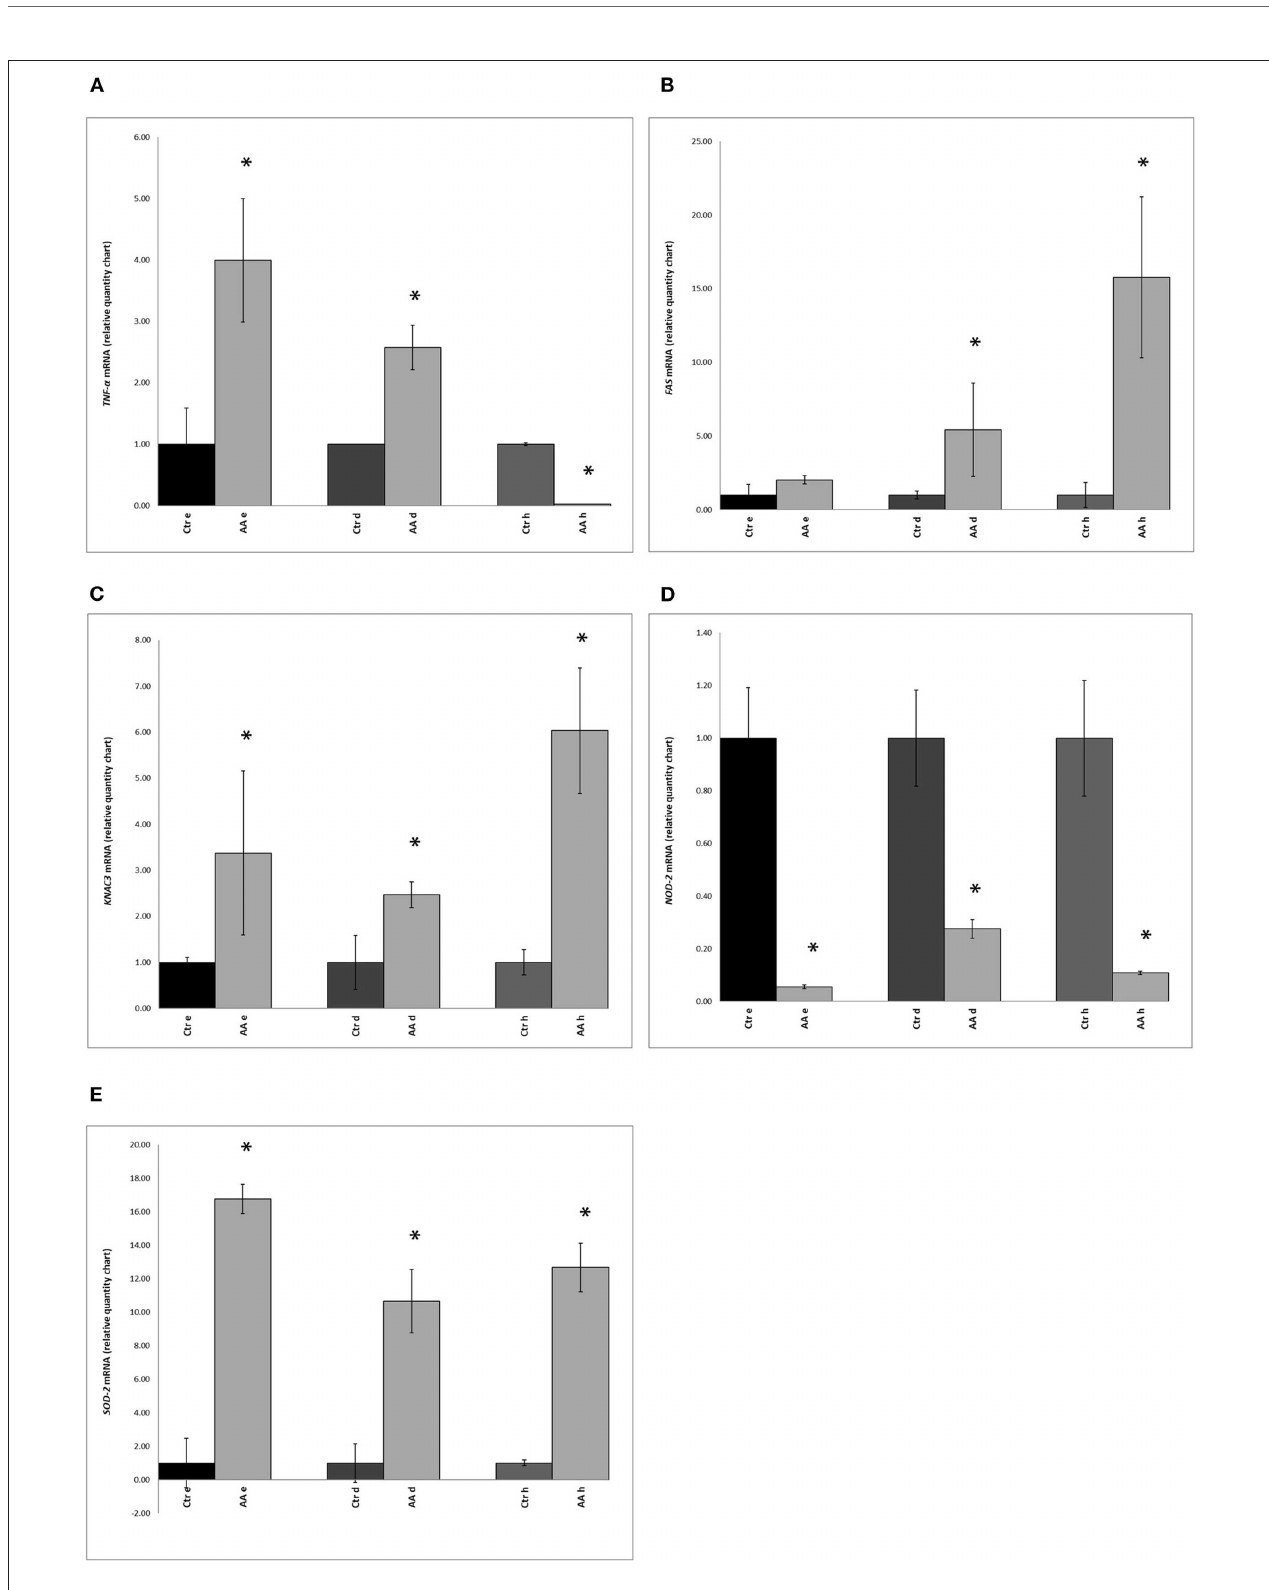
FIGURE 2 | Expression of (A) TNF- α (tumor necrosis factor-alpha), (B) FAS (Fas cell surface death receptor), (C) KCNA3 (potassium voltage-gated channel subfamily A member 3), (D) NOD-2 (nucleotide-binding oligomerization domain containing 2), and (E) SOD2 (superoxide dismutase 2) genes in biopsy samples, as determined by RT-PCR, in control (Ctr) and alopecia areata (AA) groups. Gene expression was measured in the deep epidermis (e), dermis (d), and hypodermis (h). Data represent the means ± SDs of three separate experiments performed in triplicate. Statistical differences between mean values were determined using the Wilcoxon-Mann- Whitney test. Asterisks indicate significant differences ( p <